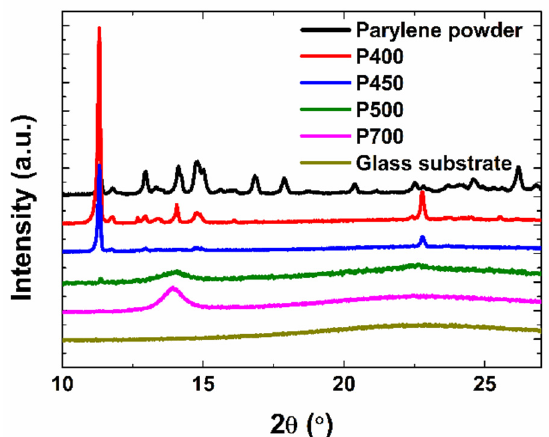
Figure 3. XRD patterns of the parylene powder; P400, P450, P500, and P700 parylene films; and the glass substrate.